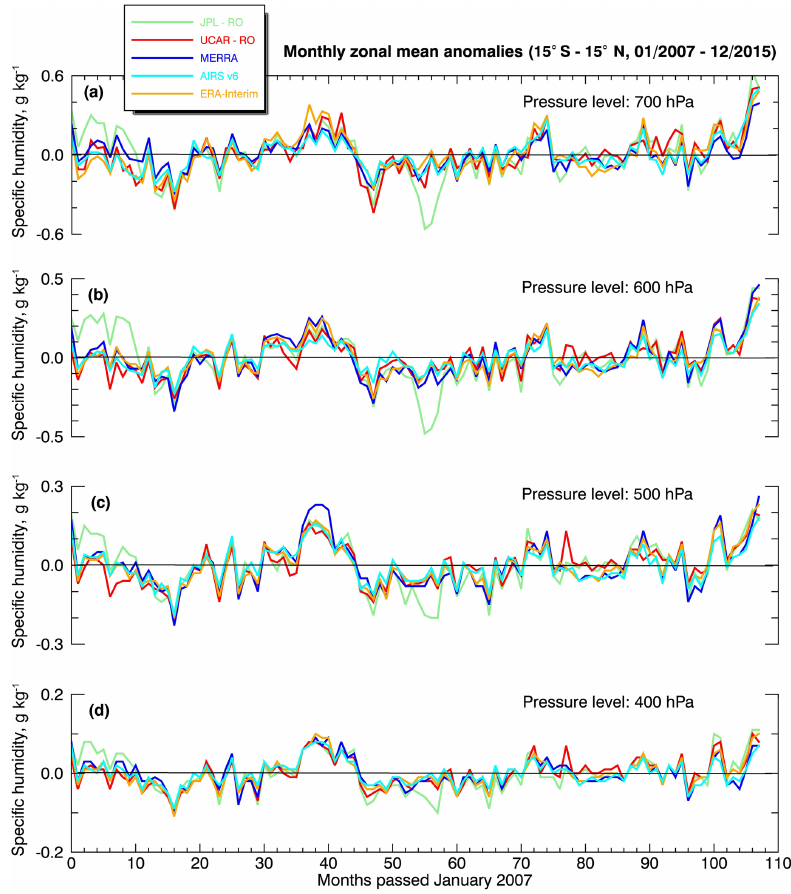
Figure 2. Same as Fig. 1 but for the specific humidity interannual